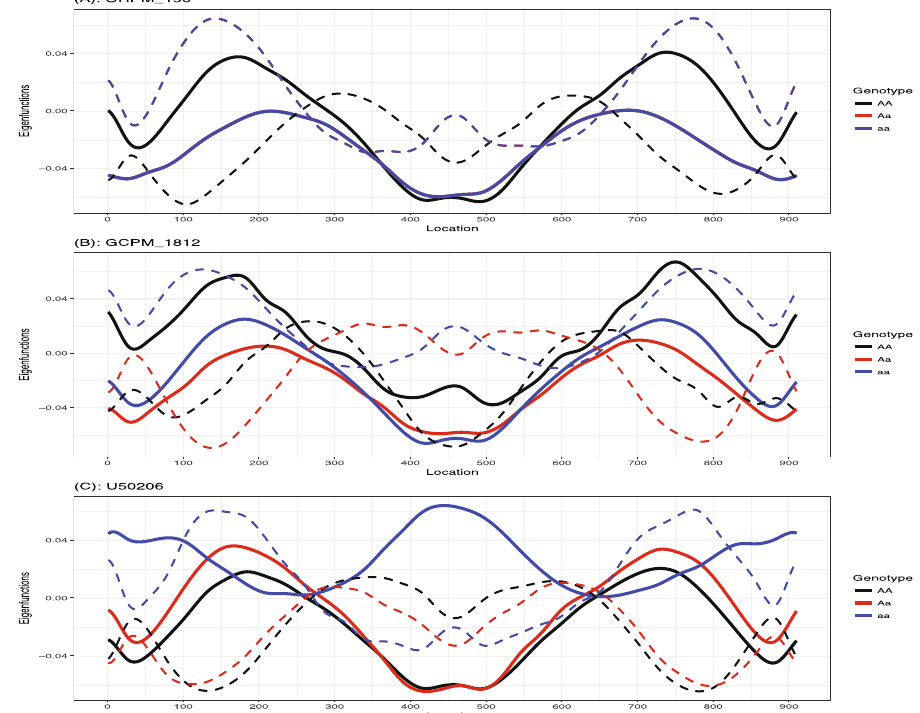
Figure 8. The first two Eigenfunctions output from the FunFor approach across all observations belong to each genotype of the top three most important markers ORPM_190 , GCPM_1812 , and U50206 . The black curve for AA, the red curve for Aa, and the blue curve for aa. Solid line for the first Eigenfunction ˆ v 1 ( t ) and the dash line for the second Eigenfunction ˆ v 2 ( t ) .